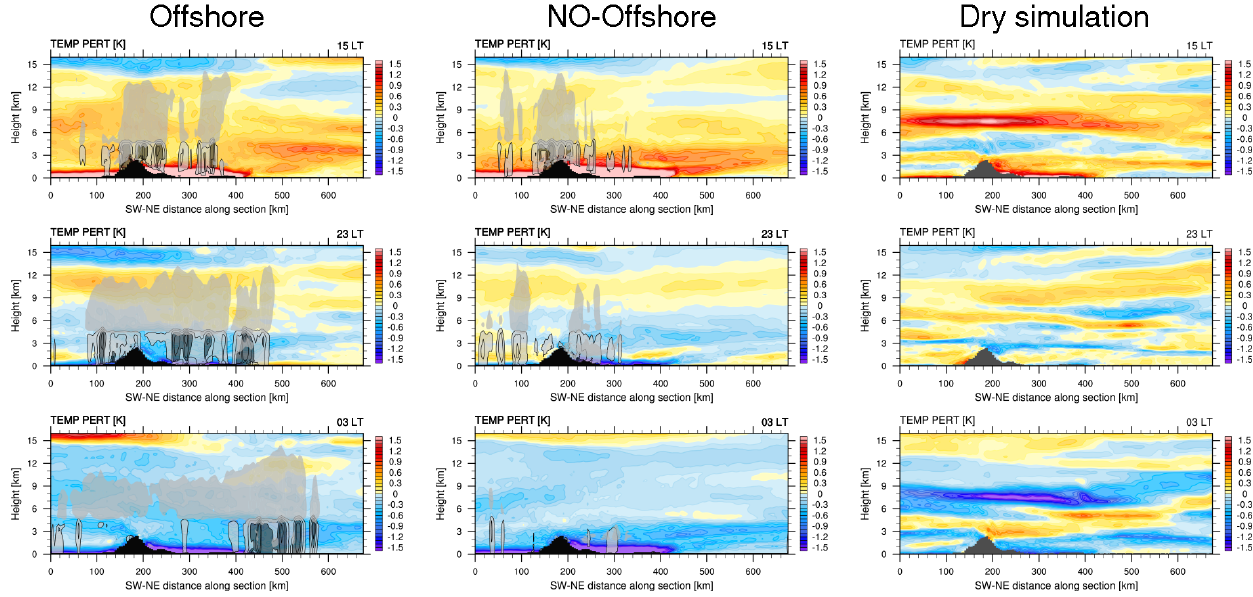
Figure 11. Temperature perturbations from daily mean (colours) for offshore (left panels), no-offshore (middle panels), and dry simulation (right panels) at 15:00, 23:00, and 03:00LT. Total condensate greater 0.05gkg − 1 is shaded grey; rain areas are contoured every 0.05gkg − 1 in black with regions greater than 0.15gkg − 1 shaded dark grey. The averaged terrain profile is shaded black.